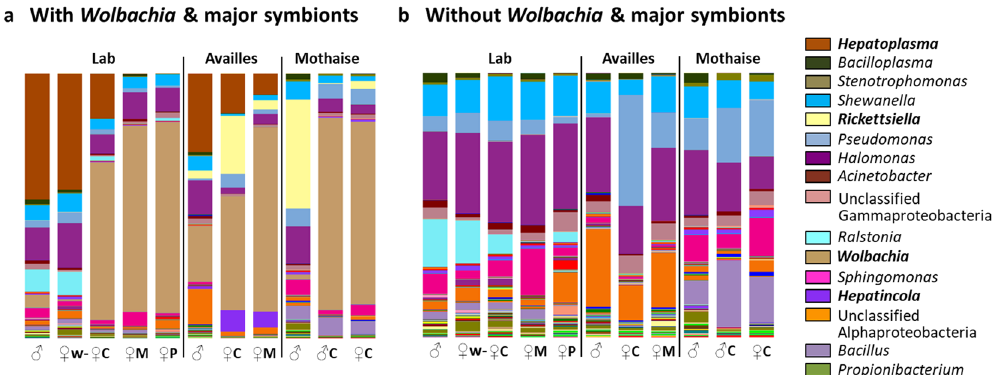
Figure 1. Microbiota composition (%) at the genus level depending on host origin, gender and Wolbachia infection. The sequencing data from five different tissues were merged in order to obtain a representative profile for each sample type. The most abundant bacterial genera are specified in the legend, their order corresponding to the order of taxa in the barplots from top to bottom. (a) represents the complete bacterial community including Wolbachia and three other highly abundant terrestrial isopod symbionts (i.e. Hepatoplasma , Hepatincola , Rickettsiella , highlighted in bold in the legend). These highly abundant taxa were removed in (b) in order to obtain a less skewed representation of the rarer